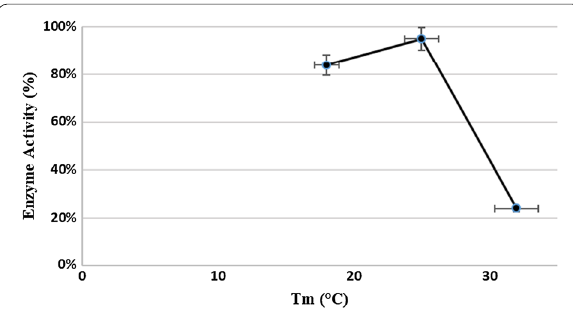
Fig. 7 Linearized Michaelis–Menten saturation curve by Lineweaver– Burk